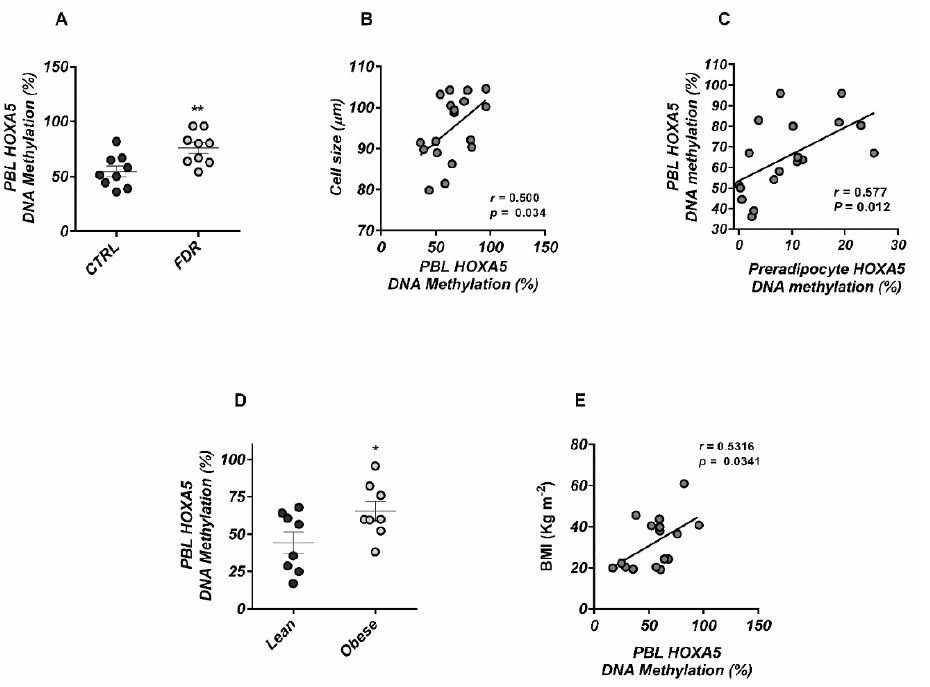
Figure 5. HOXA5 DNA methylation in peripheral blood leukocytes from FDR and CTRL subjects. ( A ) Changes in average DNA methylation levels at 36 CpG within the HOXA5 promoter were detected by BS analysis in PBL from FDR (n = 9) and CTRL (n = 9) subjects available from the study group. Mean values ± SD are also shown. ** p < 0.01 in a two-tailed Mann–Whitney U-test. ( B ) Correlation between the PBL HOXA5 methylation and the mature adipose cell size or ( C ) with the preadipocyte HOXA5 methylation in FDR (n = 9) and CTRL (n = 9) subjects available from the study group. The r correlation coefficients and p -values are indicated in the graph. HOXA5 methylation in peripheral blood leukocytes from obese and lean subjects. ( D ) BS analysis of the HOXA5 promoter